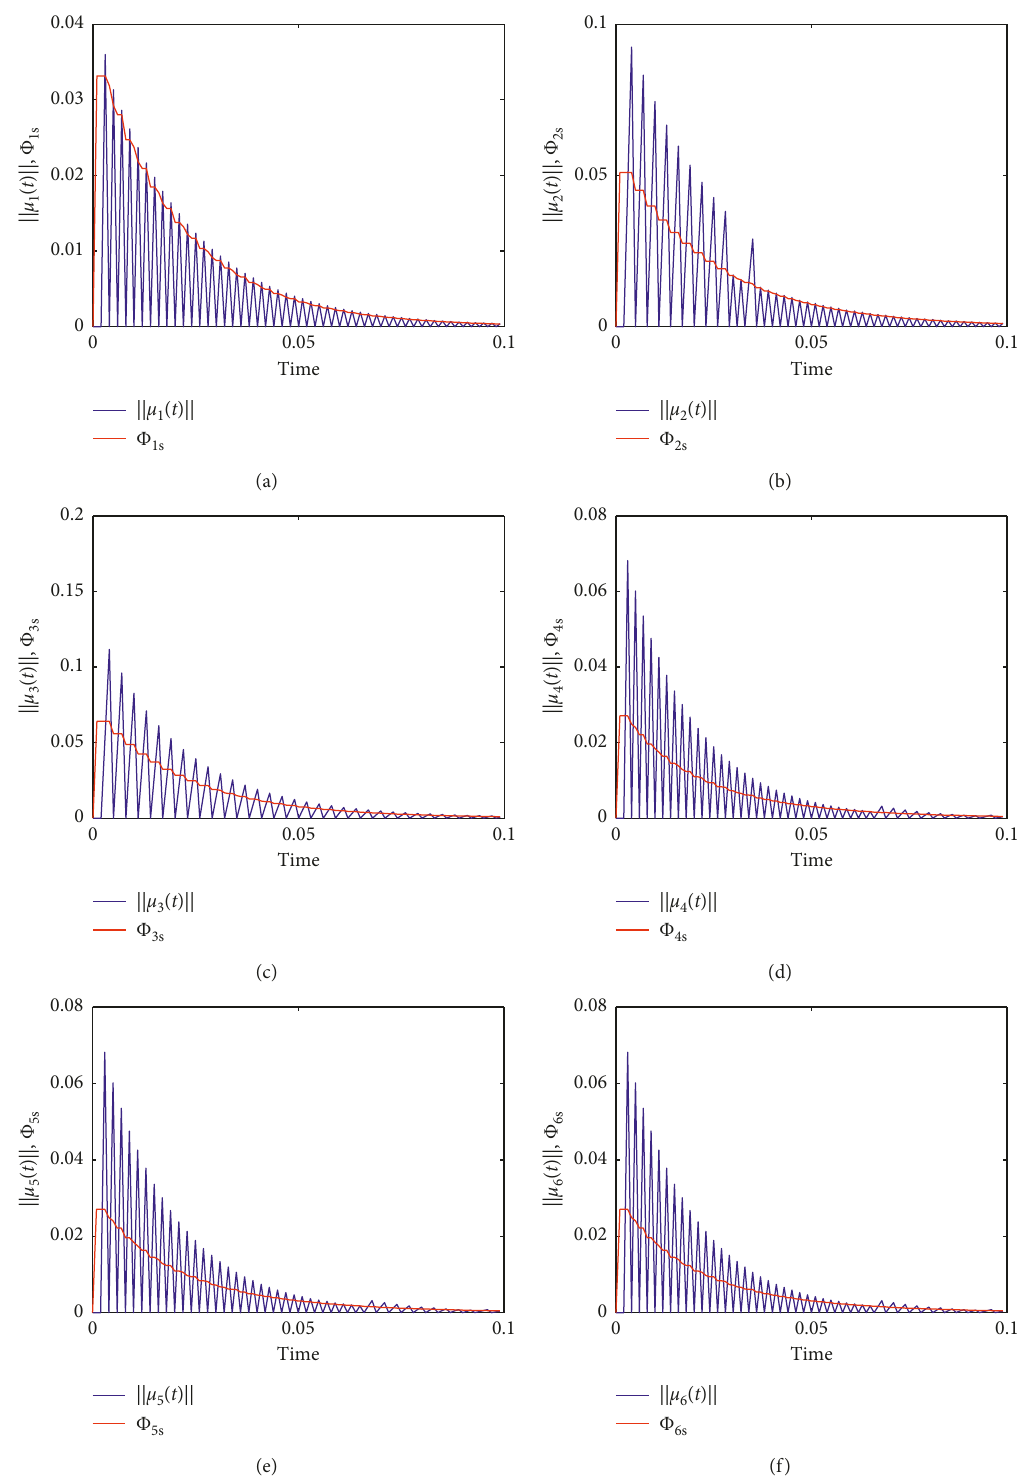
Figure 6: Time evolutions of measurement errors μ